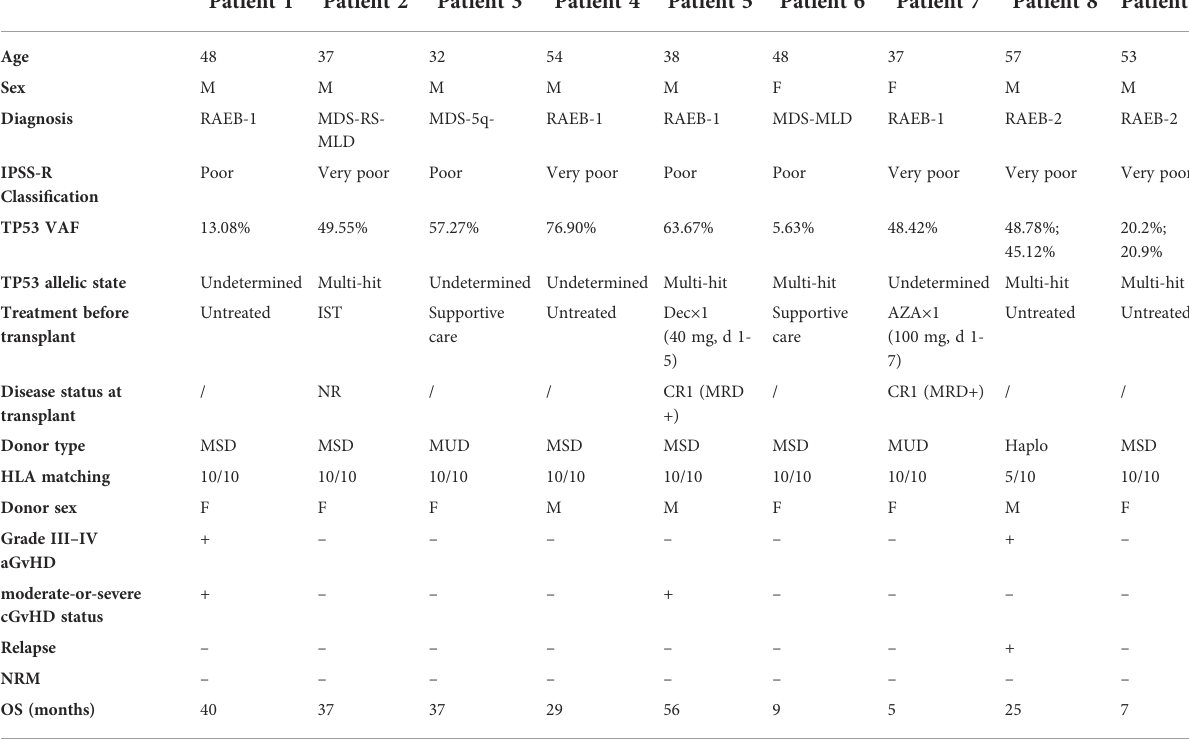
TABLE 3 Characteristics of the nine